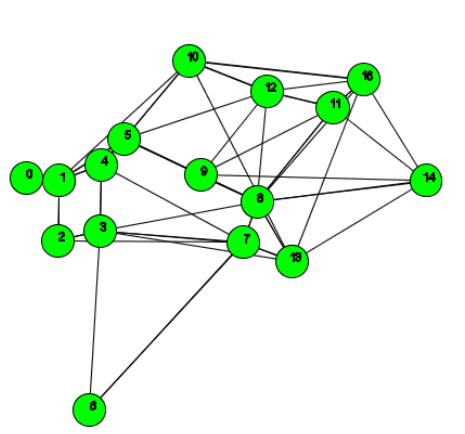
Figure 8: ...and the corresponding graph